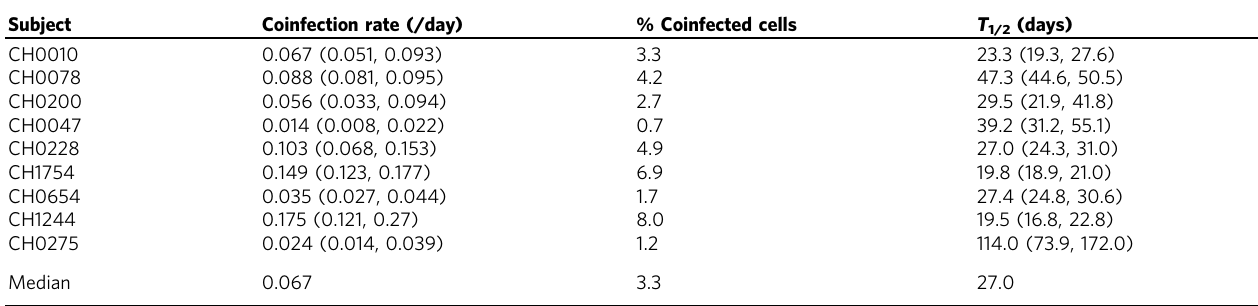
The rate of coinfection is given as γβ I , and the percentage of coinfected cells during the infection is F c = γβ I / ( γβ I + γβ T ) with γβ T = 2/day. T 1/2 indicates the predicted time when the frequency of recombinants reaches 50% of the viral population. Coinfection rate was estimated by fi tting 3 ′ and 5 ′ data simultaneously using maximum likelihood (see Methods for more detail). In CH0654, all sequences were recombinants at day 84 before the initiation of ART at day 112. Therefore, ART in CH0654 did not affect the